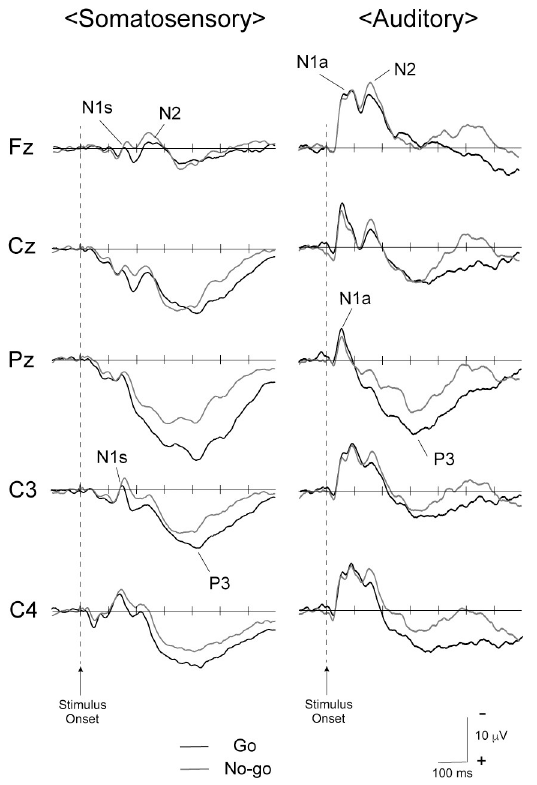
Fig 1. Grand-averaged somatosensory and auditory ERP waveforms across all participants. In the waveforms, the top is shown as negative, and the bottom is shown as positive.